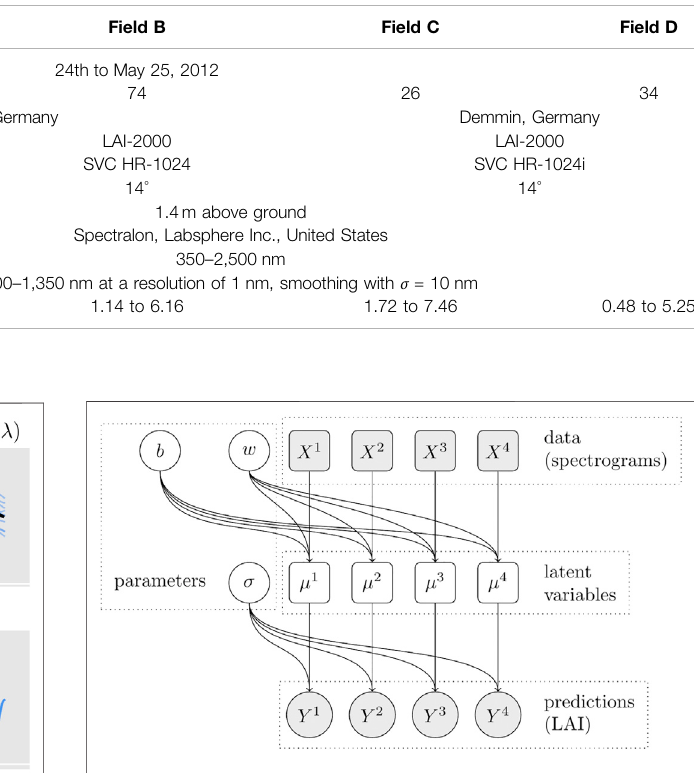
FIGURE2| Dependencygraphofthebaselinemodel.Foreachdataset j (encoded in the feature matrix X j and corresponding labels Y j ), the prediction depends on the same three shared parameters b , w and σ . Circles represent random variables, rectangles represent deterministic variables, fi lled shapes represent observed